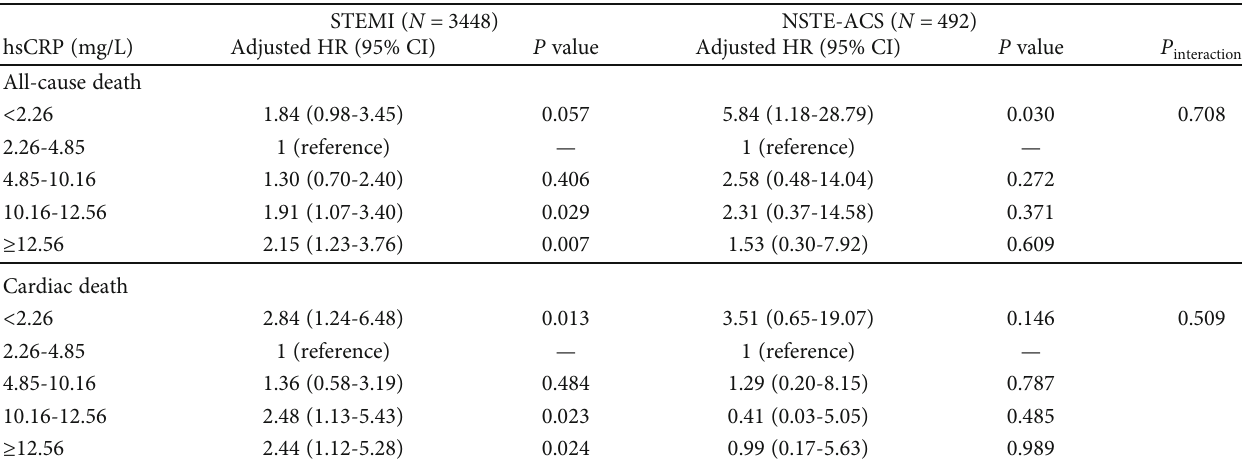
Table 4: Adjusted hazard ratio according to quintiles of postprocedural hsCRP in the subgroups of STEMI and NSTE-ACS. STEMI ( N = 3448 ) NSTE-ACS ( N = 492 ) hsCRP